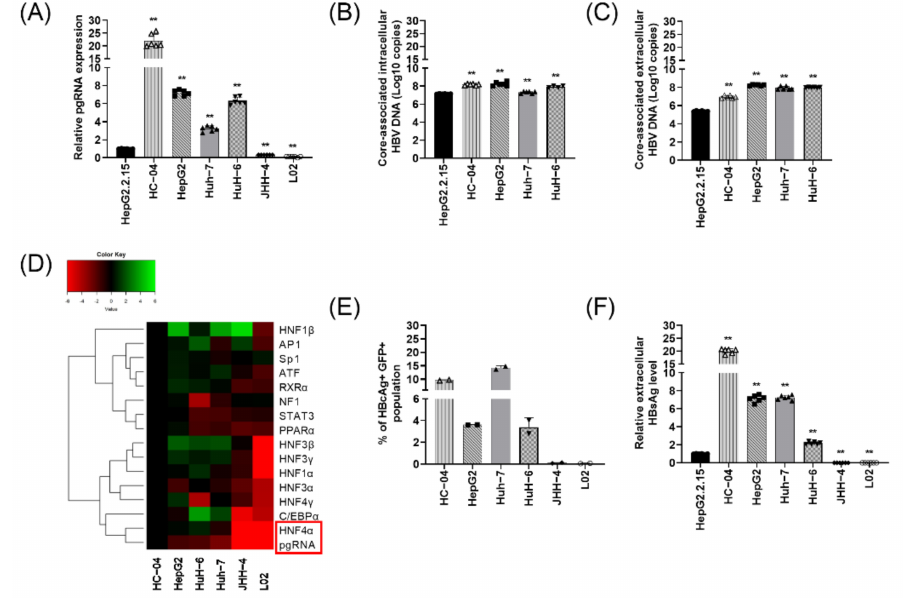
Figure 3. Efficiency of liver-derived cell transfection models in supporting hepatitis B virus (HBV) genotype B replication and gene expression. ( A ) Relative pg-RNA expression to HepG2.2.15 among the liver-derived cell transfection models at 72 h post-transfection. ** p < 0.01, T-test, by comparing each of the cell lines to HepG2.2.15. Core-associated intracellular ( B ) and extracellular HBV DNA ( C ) in cell lines with detectable pg-RNA expression level. ( D ) Hierarchy clustering analysis of relative mRNA expression of host TFs and viral pg-RNA across transfection models ( E ) The percentage of HBcAg + GFP + population measured by FACS analysis. ( F ) Secreted HBsAg in the supernatant of transfected cells measured by ELISA. Each data bar represents the average + SD from triplicate samples with two technical replicates. The relative HBsAg expression and p -value were calculated by comparing each of the cell lines to